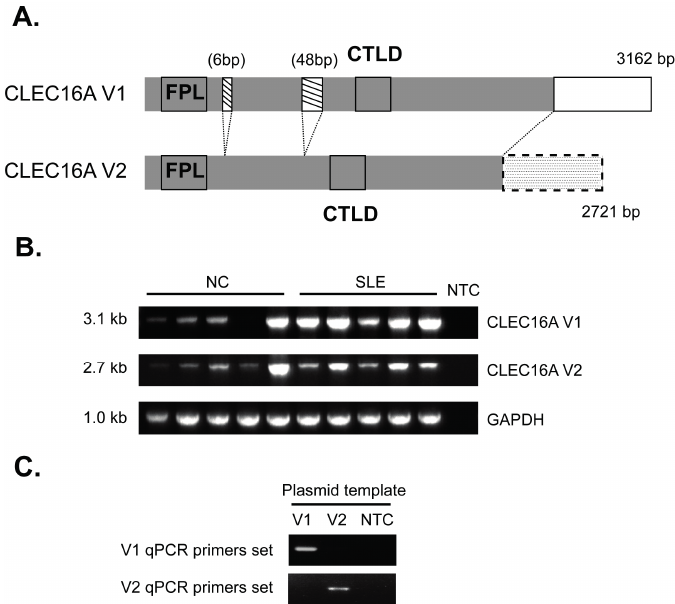
Figure 1. CLEC16A expression in peripheral blood mononuclear cells. ( A ) Schematic diagrams of two expressed transcripts of CLEC16A showing the predicted FPL and putative C-type lectin-like (CTLD) domains. Grey segments denote identical nucleotide sequences, while the open and dotted segments represent unique sequences in the 3 ′ -end regions of V1 and V2 respectively. Hatched segments represent the 6-bp and the 48-bp sequences observed in V1 but not in V2; ( B ) Full length mRNA transcripts of V1 and V2 could be amplified by RT-PCR from PBMCs of healthy normal controls (NC) and lupus (SLE) patients. Five representative samples from each group are shown. GAPDH was used as an internal control. NTC represents no template control; and ( C ) Specificity of qPCR primer sets for V1 and V2 was tested by conventional PCR using V1 and V2 plasmids as templates. No cross amplification was